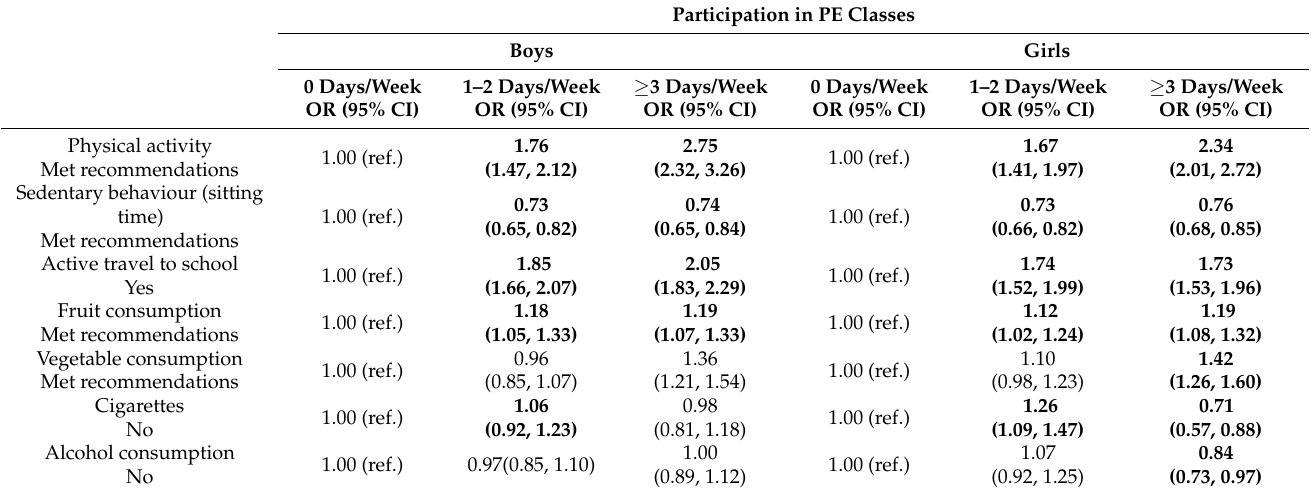
Table 3. Relationship between meeting healthy behaviour recommendations and participation in PE classes.